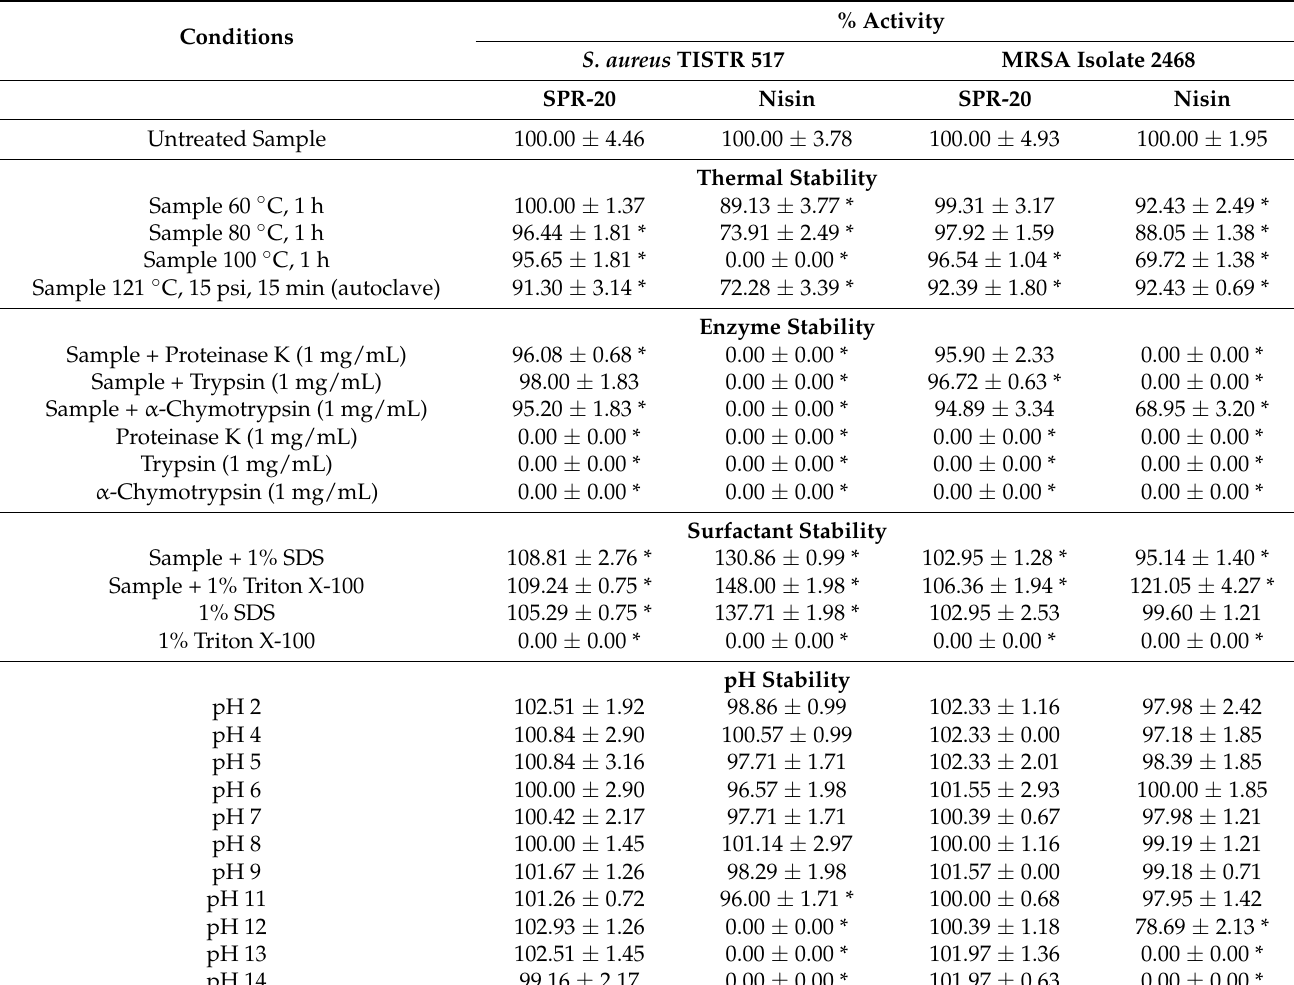
Table 3. Stability study of antibacterial substances from Brevibacillus sp. SPR-20 and nisin (standard peptide antibiotic; 200 µ g). The percent activity is expressed by the ratio between the inhibition zone of treated and untreated samples (mean ± SD, n =